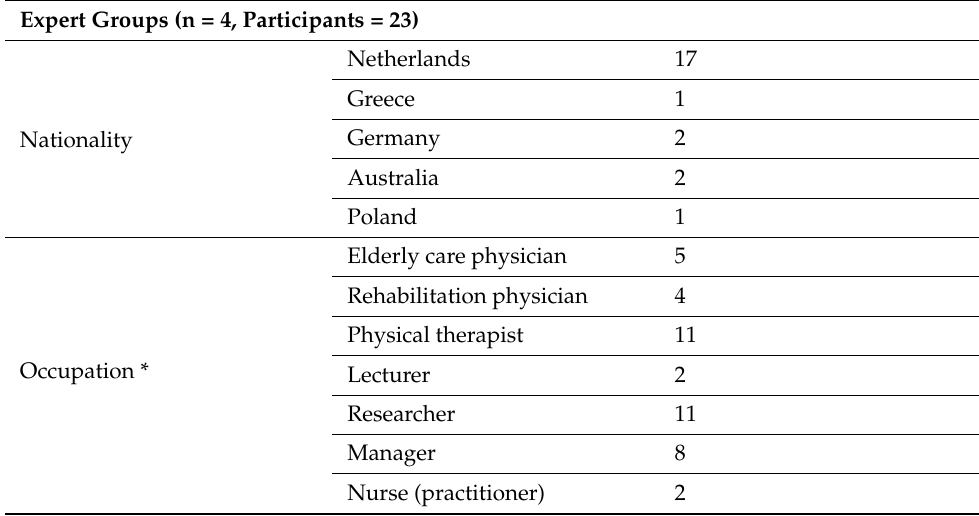
Table 1. Characteristics of